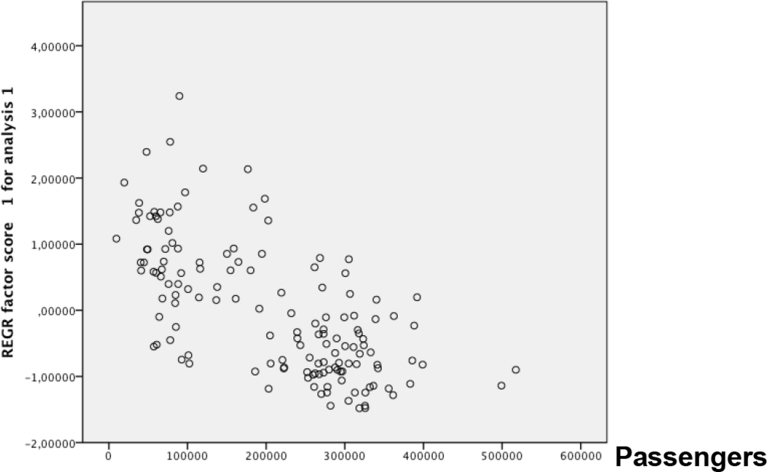
Regression analysis.